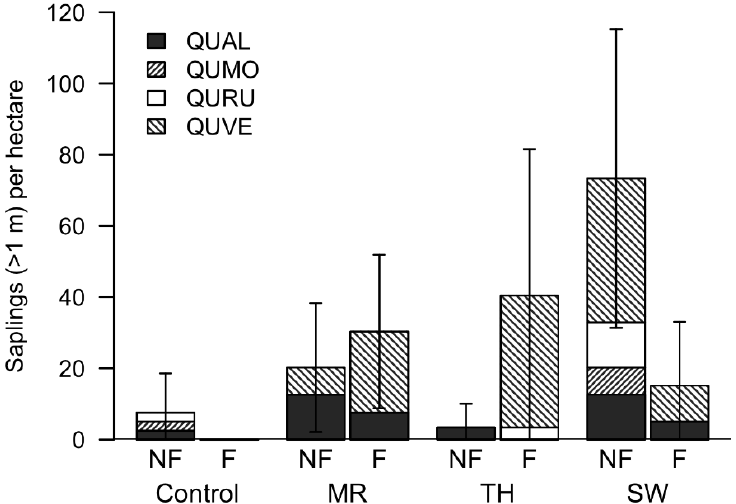
Figure 5. Mean (±SE) density of oak ( Quercus ) saplings (>1 m) per ha, ten growing seasons after midstory removal (MR), crown thinning (TH), and shelterwood (SW) treatments, with deer fencing (F) and without fencing (NF). Only year ten is displayed due to very few oak individuals tall enough to be counted in the sapling plots in previous sampling years.